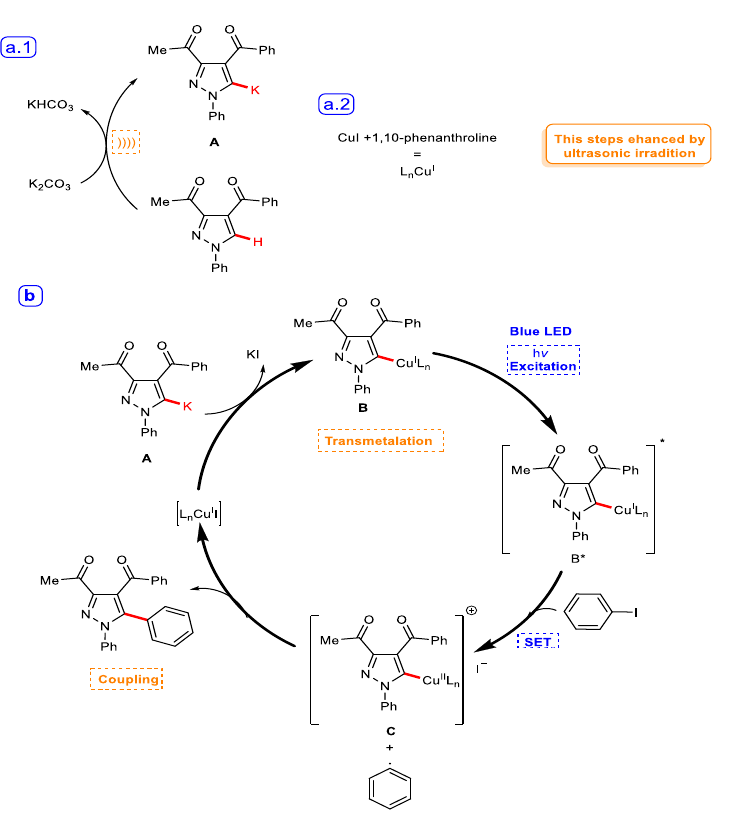
Figure 4. Single-crystal X-ray of compound